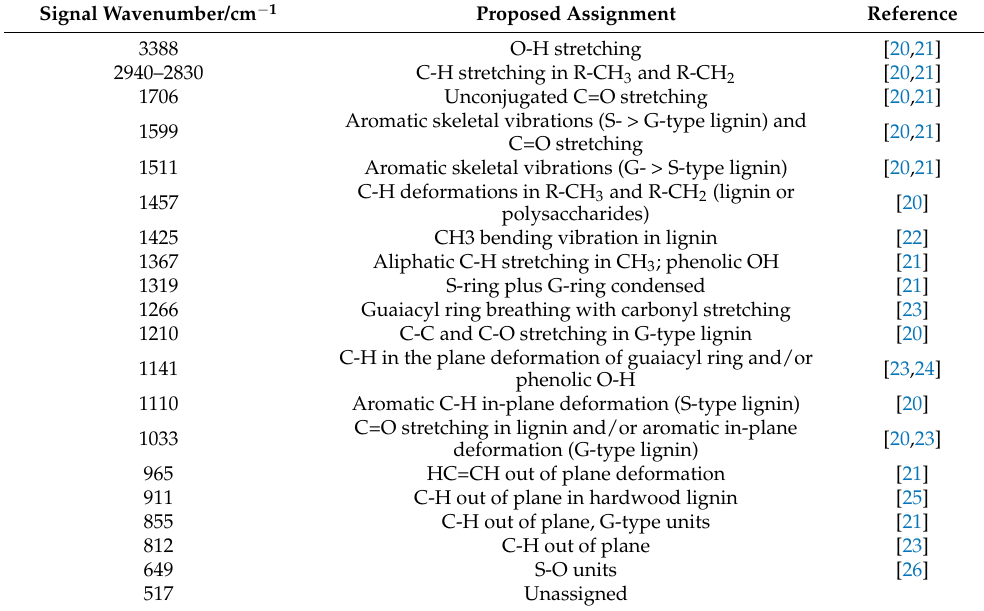
Figure 2. Normalized FTIR spectra of the four untreated technical lignins: LS (green; dashes–dots); BOSL (blue; dots); SOSL (red; dash); PKL (black; solid line). The proposed assignments of the signals are listed in Table 1. Table 1. Signal maximum wavenumber, proposed assignment of the signal, and literature source for the assignment of the four technical lignins (see Figure 2).